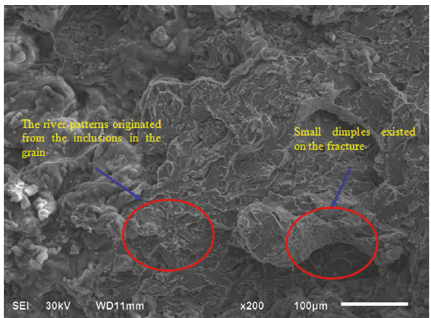
Figure 8: Fracture morphology of tensile specimen of 4340 steel.